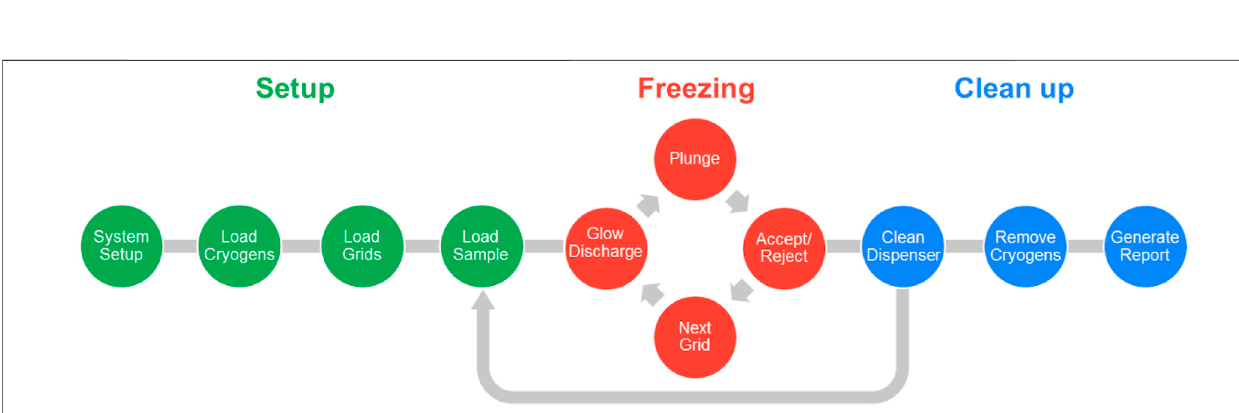
Frontiers in Molecular Biosciences |